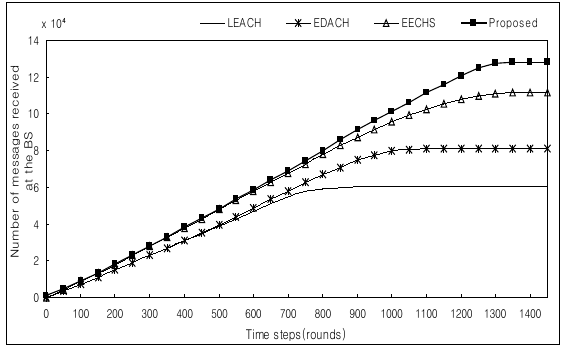
Fig. 6. The Total number of message received by the BS.